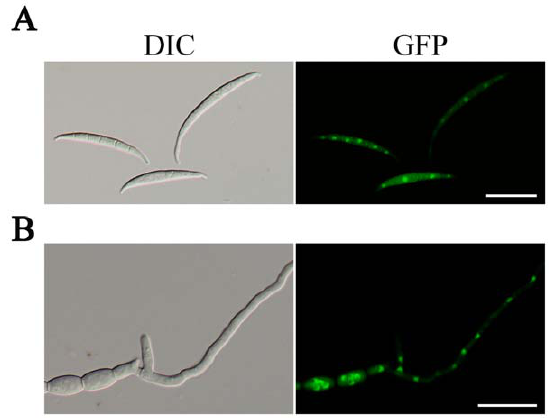
Figure 5. Subcellular localization of Amt1-GFP fusion proteins. Conidia ( A ) and 7 h germlings ( B ) of the D amt1/AMT1 -GFP transformant (Y5) were examined by phase contrast (DIC) or epifluorescence (GFP) microscopy. GFP signals were present in both the cytoplasm and nucleus but were stronger in the nucleus. Bar=50 m m.